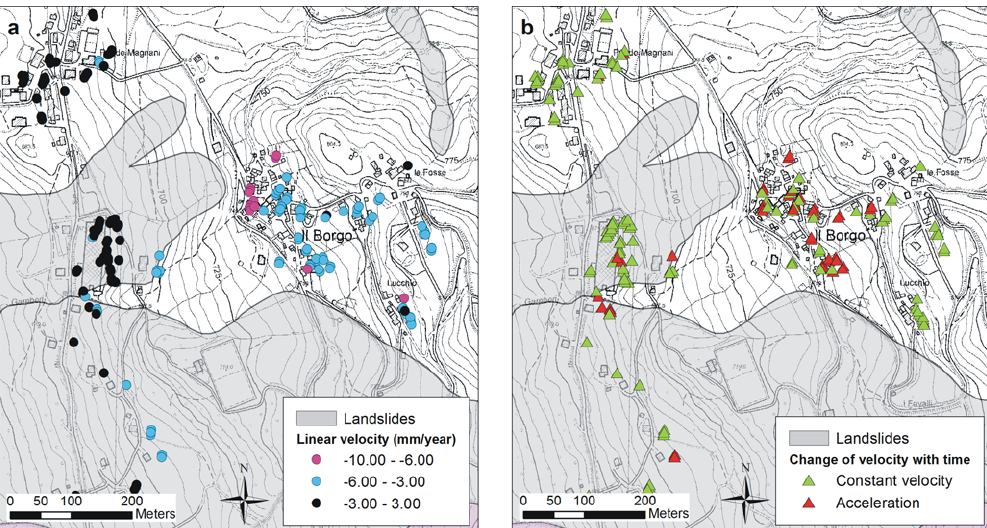
Fig. 13. (a) mean PS velocity in the area of Il Borgo (Bologna province, northern Apennines of Italy); (b) PS classification according to the temporal variation of velocity: constant velocity characterizes uncorrelated (type 0) or linear (type 1) time series, acceleration indicates bilinear time series (type 3) with an increasing velocity after the breakpoint.